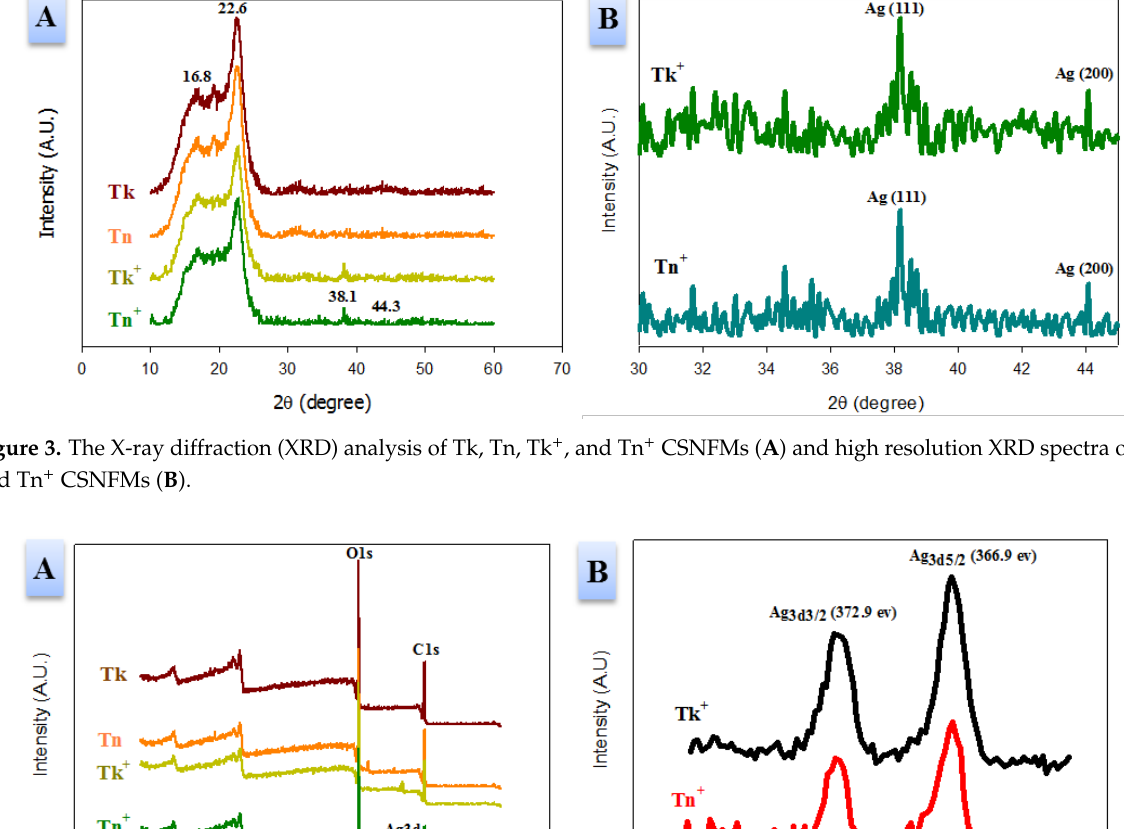
Figure 3. The X-ray diffraction (XRD) analysis of Tk, Tn, Tk + , and Tn + CSNFMs ( A ) and high resolution XRD spectra of Tk + and Tn + CSNFMs ( B ).